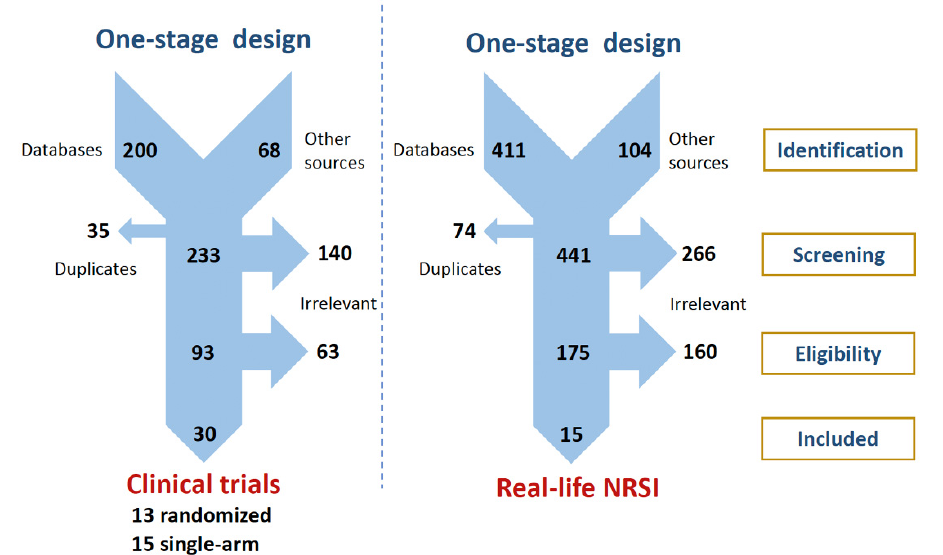
Figure 1. PRISMA flowcharts presenting our parallel one-stage systematic review selection process for retrieving complement inhibition evidence on clinical trials and real-life NRSI. NRSI, non-randomized studies of the effects of interventions; PRISMA, Preferred Reporting Items for Systematic Reviews and Meta-Analyses.